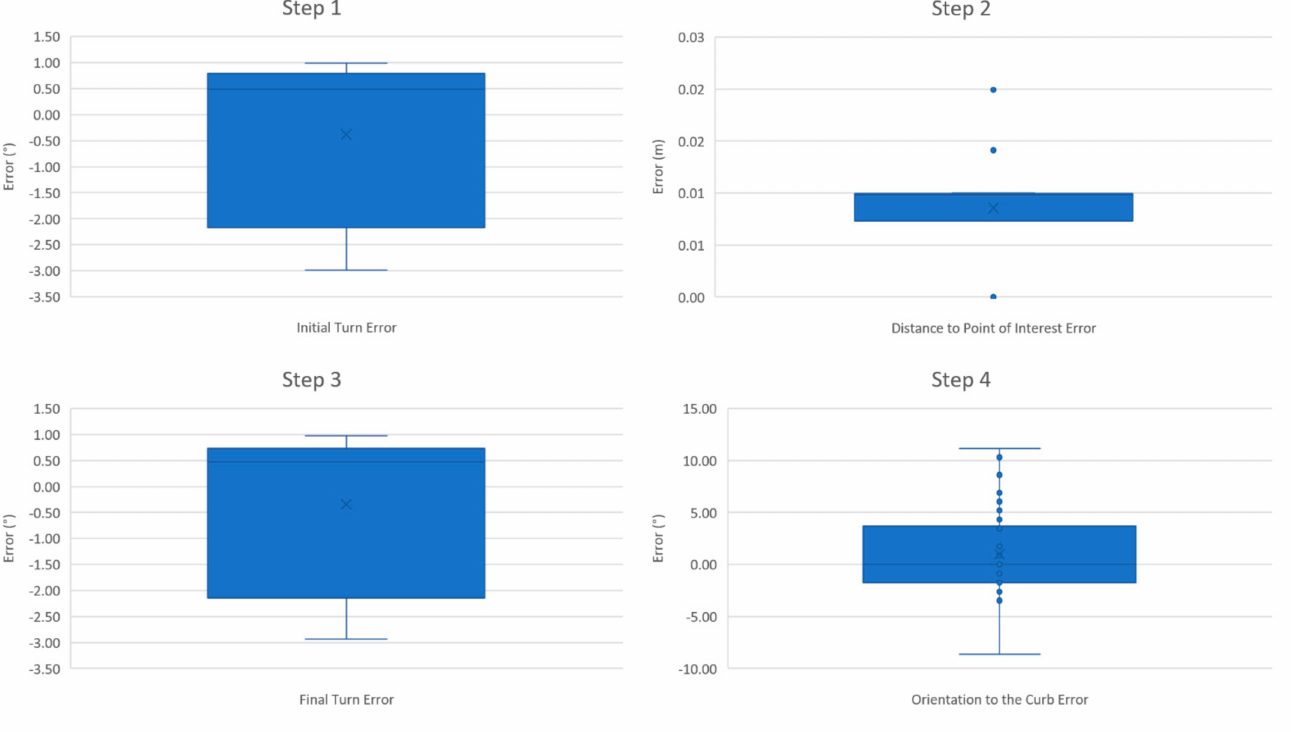
Figure 12. Box and whiskers error plots of the stepwise